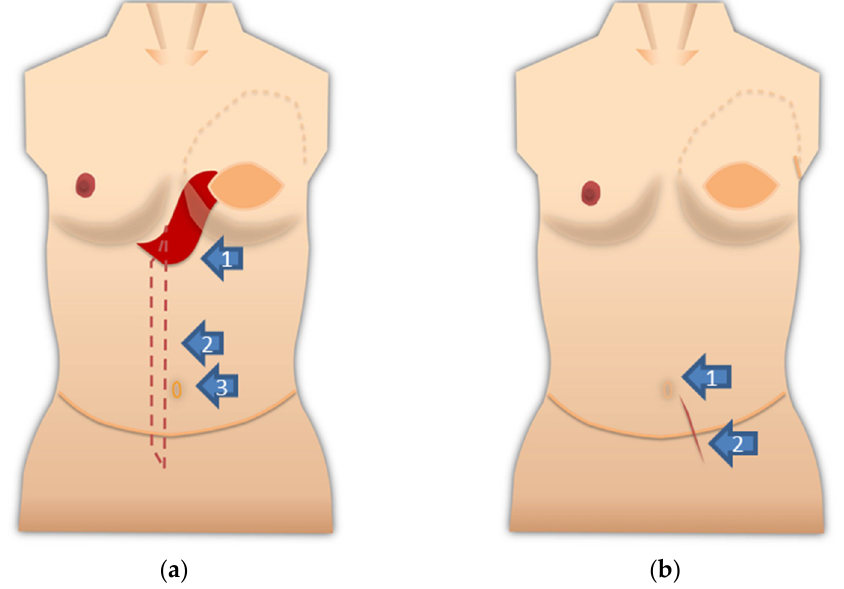
Figure 2. ( a ) Notes on port placement are shown on the schema after VRAM/TRAM reconstruction. Do not apply prolonged pressure to the rectus abdominis fold and avoid port placement (arrow 1: the red area is the fold of the rectus abdominis muscle). There is a defect in the rectus abdominis muscle (arrow 2: red dotted line area). The anterior sheath of the rectus abdominis muscle is sutured. The port should not be placed here. Arrow 3 points to the umbilicus. The umbilicus is split lengthwise into exactly two pieces. Alternatively, a port can be placed transabdominally from the side where the rectus abdominis muscle remains; ( b ) notes on port placement are shown on the schema after DIEP reconstruction. Port insertion in this area should be avoided if possible. The umbilicus should be divided into exactly two parts, or if possible, the port should be placed in a position that will not damage the umbilical root (Arrow 1). The anterior sheath of the rectus abdominis muscle is incised and sutured for graft harvesting of the DIEP flap (arrow 2).